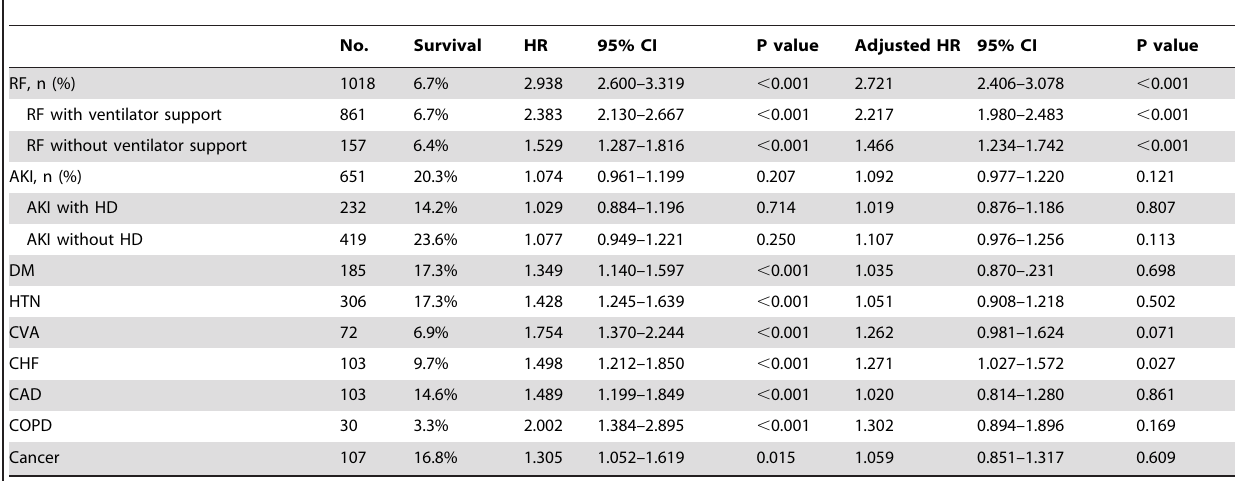
Table 3. Hazard ratio and adjusted (age and sex) hazard ratio in patients with paraquat poisoning with different comorbidities.